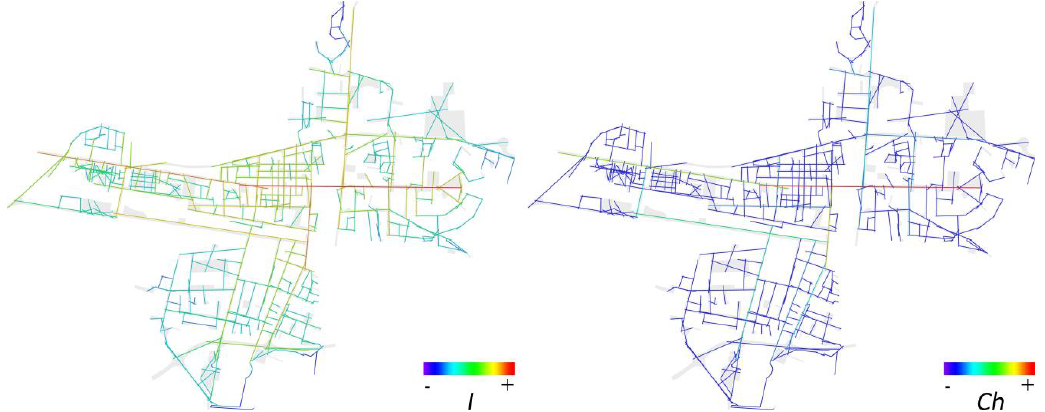
Figure 4. Results of the axial analysis of Pontedera, colour maps of: integration index, I ( left ), and choice index, Ch ( right ).